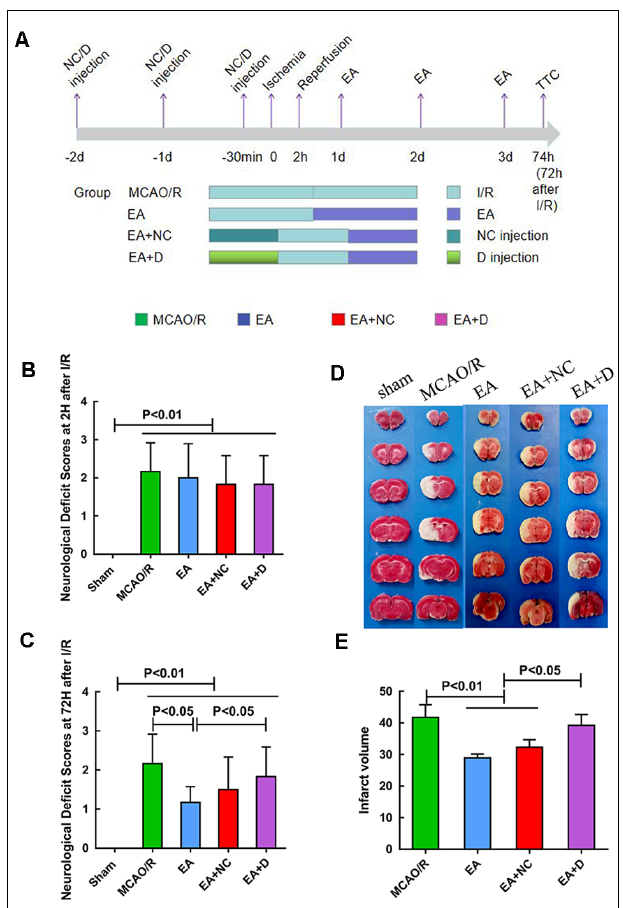
FIGURE 1 | The pathology of an injury following ischemia/reperfusion (I/R) within 3 days. (A) Experimental groups and the protocol. (B) Neurological deficit assessment at 2 h after I/R injury. (C) Neurological deficit assessment at 72 h after I/R injury. (D) 2,3,5-triphenyl tetrazolium chloride (TTC) staining for cerebral infarct volume of the sham, MCAO/R, EA, EA+NC, and EA+D groups. (E) Bar graph showing the percentage of cerebral infarct volume among the four